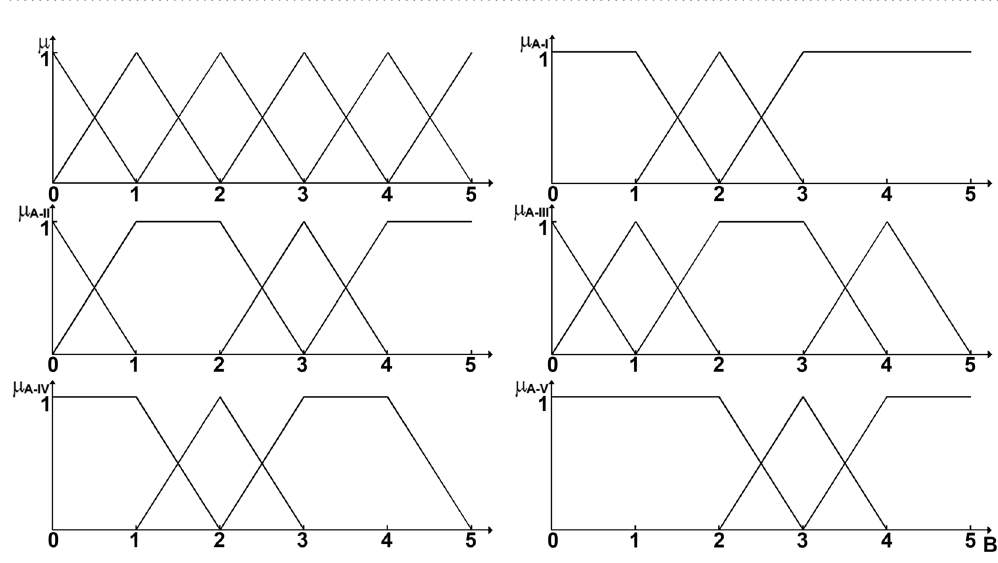
Figure 7. Levels of DQI (Set  B